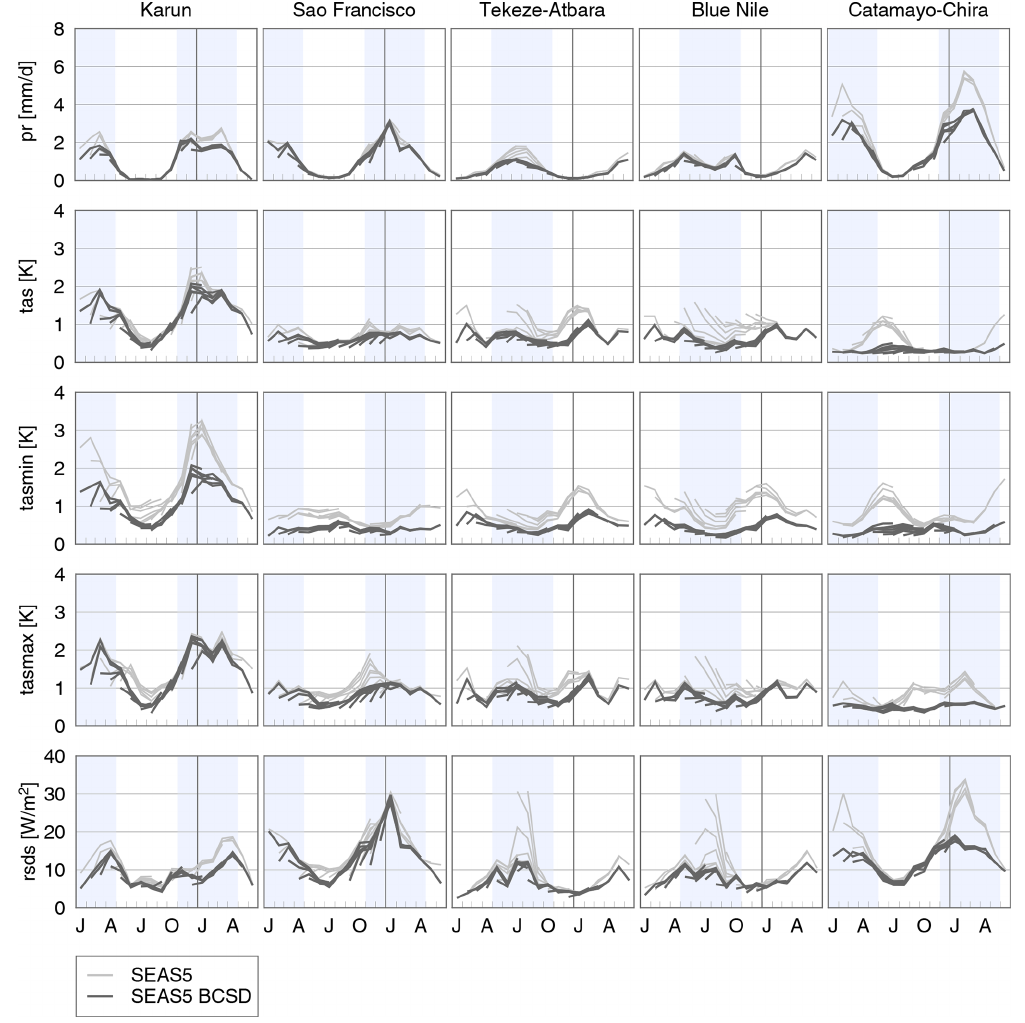
Figure 3. Same as Fig. 2 but for the RMSE of SEAS5 and SEAS5 BCSD compared to